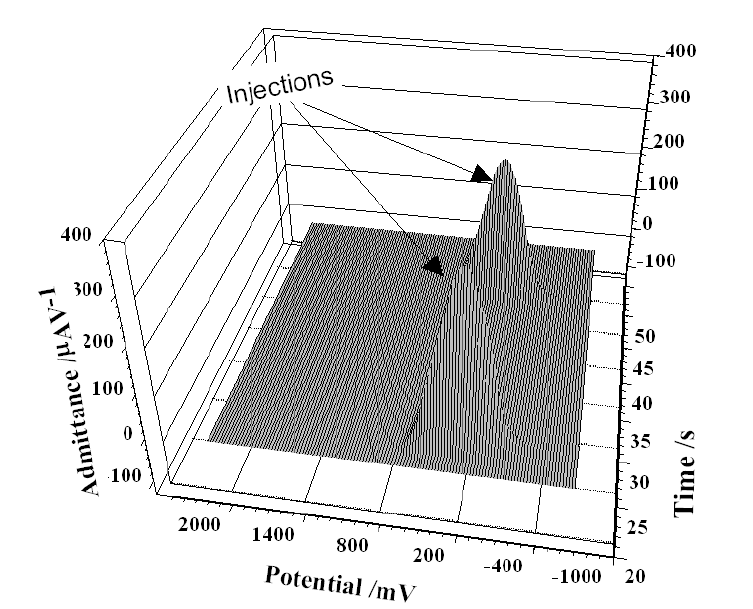
Figure 8. FFT Square-Wave voltammograms at a DyNW/CPE recorded during some injection experiment. The bulk solution was 0.05 M of acetate buffer., and the